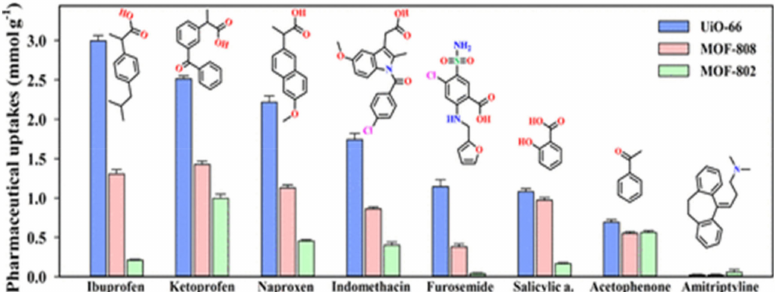
Figure 9. Adsorption capacities of UiO-66(Zr), MOF-808(Fe), and MOF-802(Fe) for the removal of pharmaceutical drugs from water. Reproduced with permission from Reference [224].